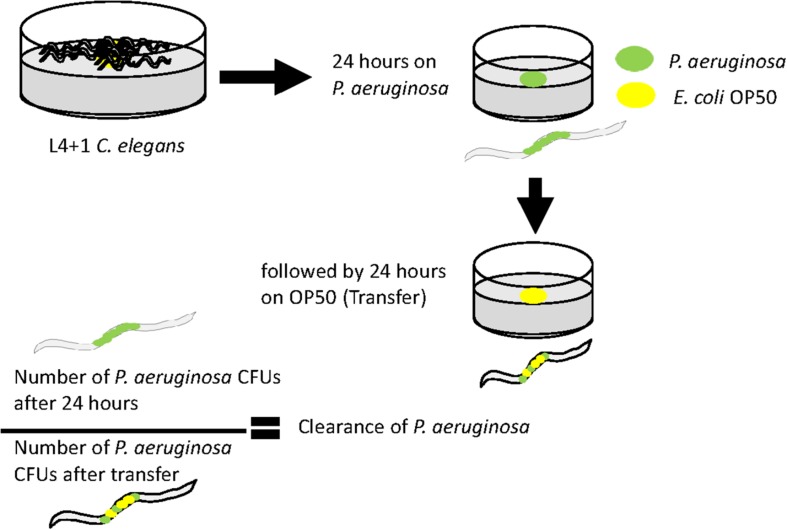
Methods for measuring clearance of P. aeruginosa from the C. elegans intestine after transfer to lawns of E. coli OP50. Age-synchronized 1 day old adult hermaphrodites were grown on a lawn of each P. aeruginosa strain before transfer to a lawn of E. coli OP50 for a further 24 h. Worms were analyzed for P. aeruginosa content immediately before and after transfer to E. coli OP50. The ratio of the CFU’s at each of these time points is an indicator of the clearance of P. aeruginosa from the intestine during exposure to E. coli.